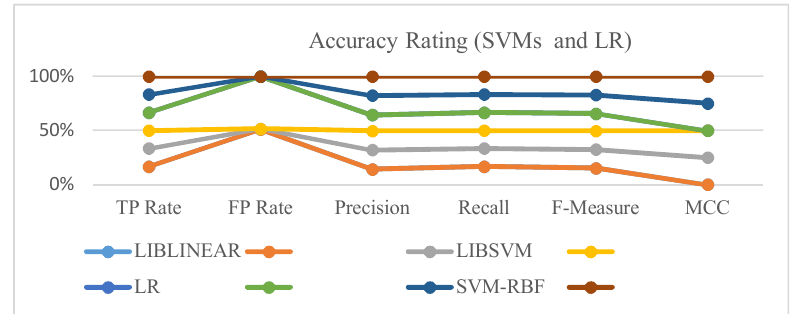
Figure 4. Accuracy rating (SVMs and LR).